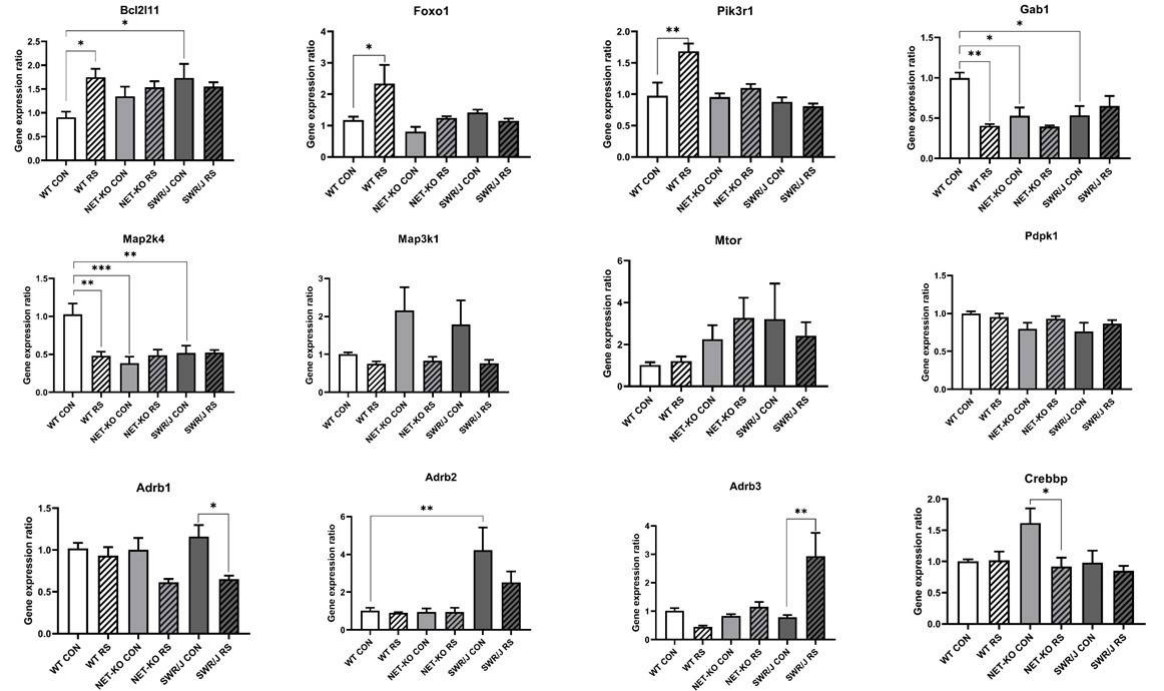
Figure 4. The expressions of mRNA-encoding genes that were regulated by mmu-let-7e-5p in the prefrontal cortex (PFC) of wild-type (WT), norepinephrine transporter knock-out (NET-KO) and Swiss (SWR/J) mice under the control condition (CON) and following stress (RS). Bcl2l11—BCL2-like 11 (apoptosis facilitator); Foxo1—forkhead box O1; Pik3r1—phosphoinositide-3-kinase regulatory subunit 1; Gab1—growth factor receptor-bound protein 2-associated protein 1; Map2k4—mitogen-activated protein kinase kinase 4; Map3k1—mitogen-activated protein kinase kinase kinase 1; Mtor—mechanistic target of rapamycin kinase; Pdpk1—3-phosphoinositide dependent protein kinase 1; Adrb1—adrenergic receptor, beta 1; Adrb2—adrenergic receptor, beta 2; Adrb3—adrenergic receptor, beta 3; Crebbp—CREB binding protein. * p ≤ 0.05, ** p ≤ 0.01; *** p ≤ 0.001; n = 4.